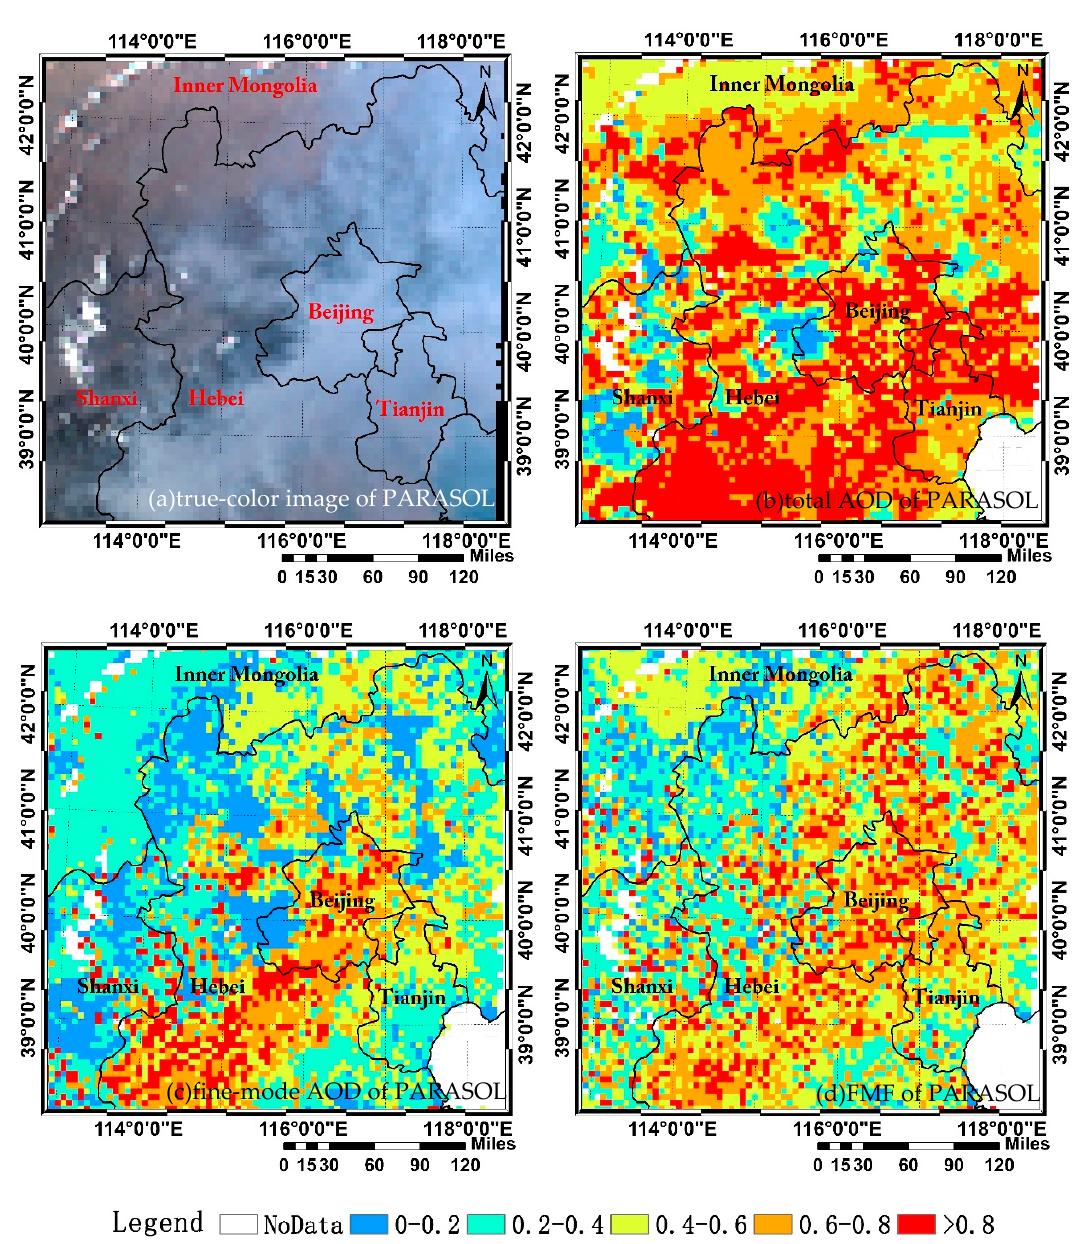
Figure 4. The retrieval results of PARASOL for 5 October 2013. ( a ) is a true-color image, and ( b ), ( c ), and ( d ) are the retrieval results of the total AOD (865 nm), fine-mode AOD (865 nm), and FMF (865 nm), respectively.